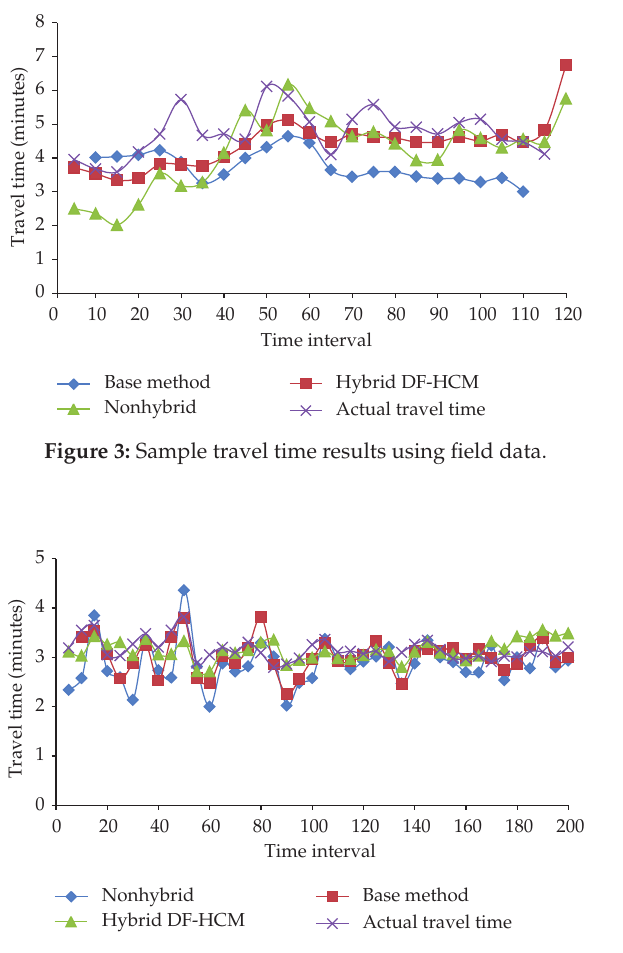
Figure 4: Travel time comparison for a 2hrs simulated data.